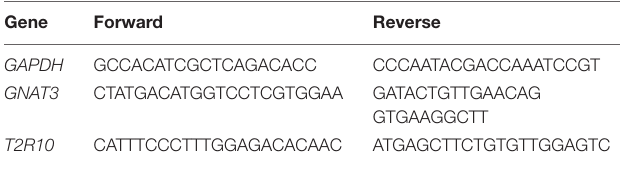
TABLE 1 | Sequence information for real-time quantitative PCR